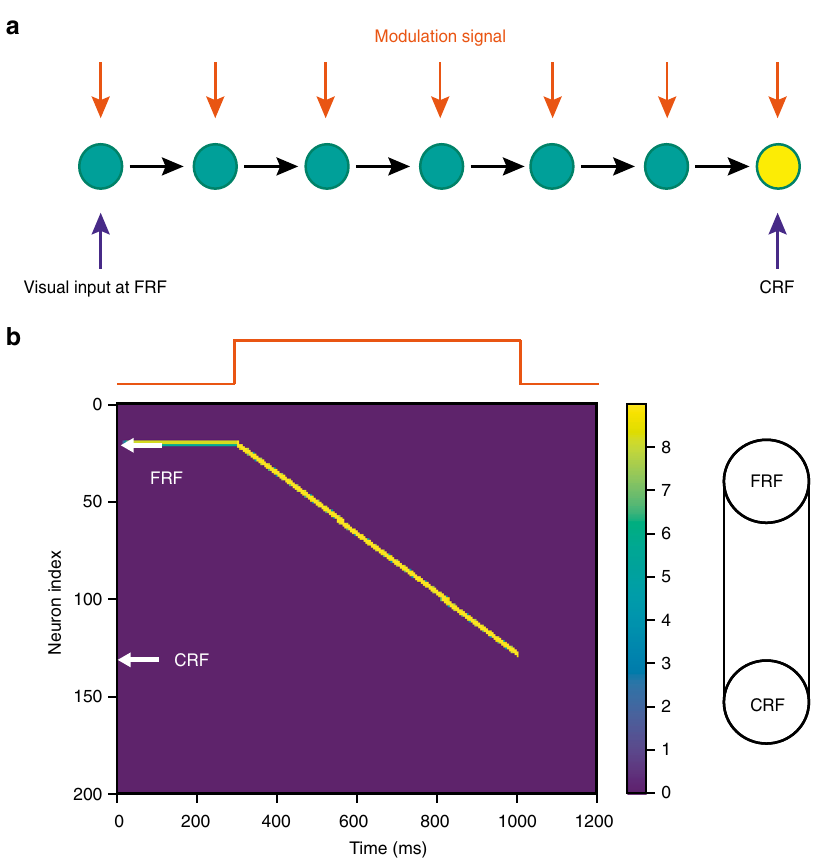
Fig. 8 A network of memristive neurons with gain modulation for receptive fi eld remapping. a A one-dimensional network where neurons are connected in an uni-direction. Each neuron receives a modulatory signal (orange arrow). A visual input is applied at the future receptive fi eld (FRF) of a neuron (the yellow one). b The visual input at FRF and the modulatory signal (top, red line) triggers a propagation of neural activity from FRF to current receptive fi eld of the yellow neuron, as if the receptive fi eld of the yellow neuron is temporally expanded when the modulatory signal is applied, achieving RF remapping (right panel). The distance of remapping is controlled by the duration of the modulatory signal. In the simulation, the visual input is applied during 0 − 300 ms, while the modulatory signal m = 0.8 is applied during 300 − 1000 ms. θ thr = 0.41, W i,i-1 = 0.095, τ = 10 ms, dt = 1 ms, I ext,0 =